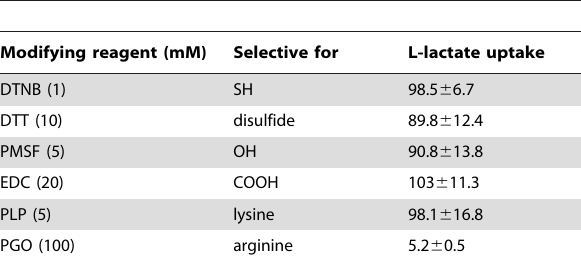
Table 2. Effects of amino acid-modifying agents on the transport system for L-lactate in hMCT4-expressing oocytes.